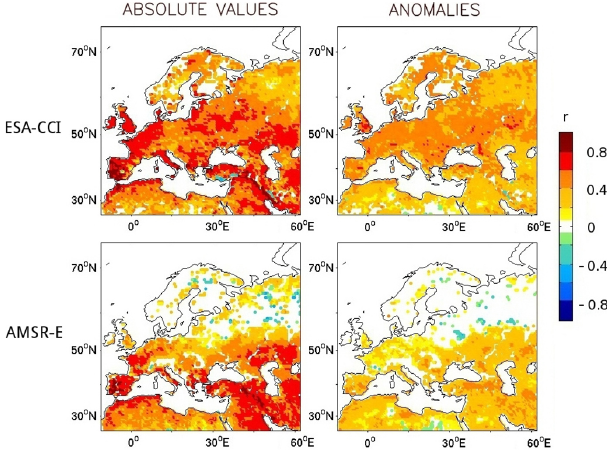
Figure 4. Same as Fig. 3, except for the 2003–2008 period and